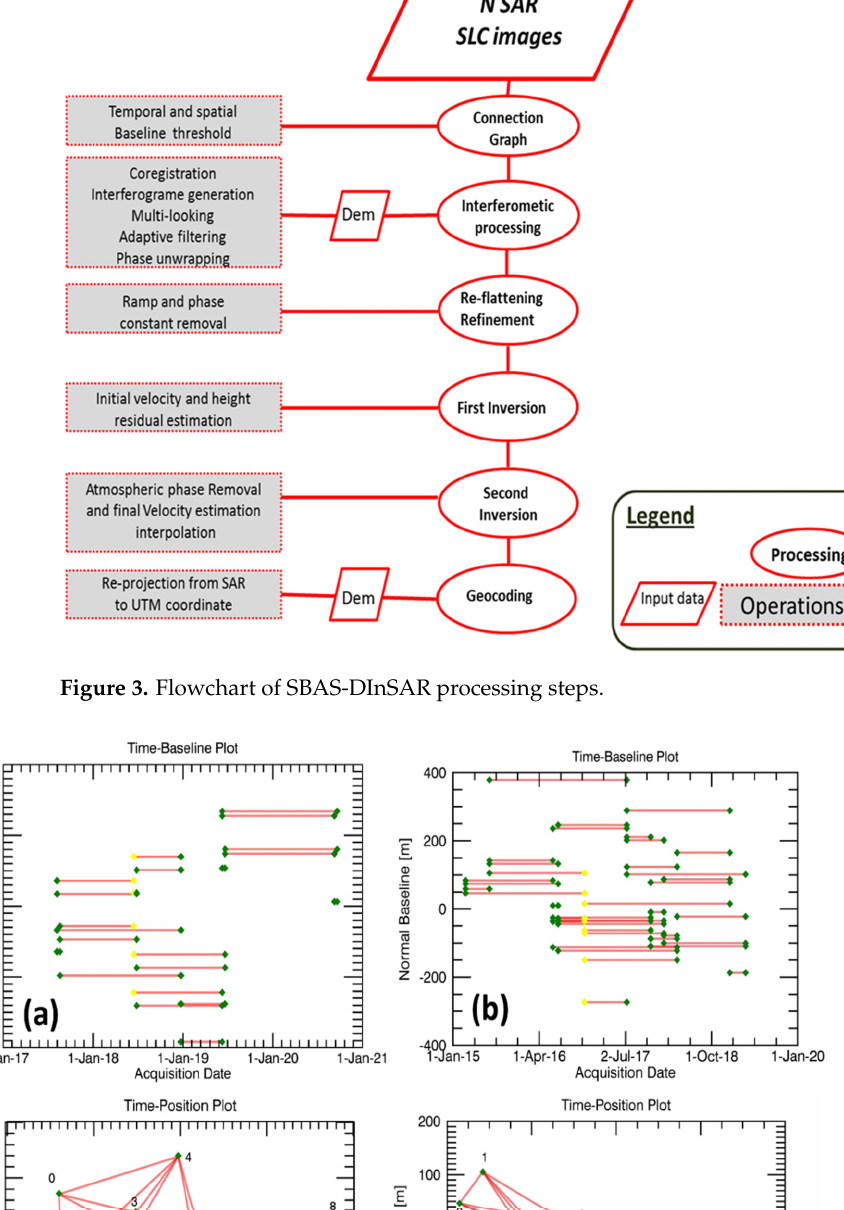
Figure 4. The temporal and spatial baseline distributions of the SAR interferograms from the Sentinel-1A and ALOS/PALSAR-2 data sets ( a – d ), where each acquisition is represented by a diamond associated to an ID number; the green diamonds represent the valid acquisitions and the yellow diamonds represent the super master image of the small baseline subset (SBAS). ( a ) Time–baseline plot of SBAS interferograms generated by the Sentinel-1A data, with 27 June 2018 as the super master image ( b ) time–baseline plot of SBAS interferograms generated by the ALOS/PALSAR-2 data, with 27 November 2016 as the super master image; ( c ) time–position plot generated by the Sentinel-1A and ( d ) time–position plot generated by the ALOS/PALSAR-2.